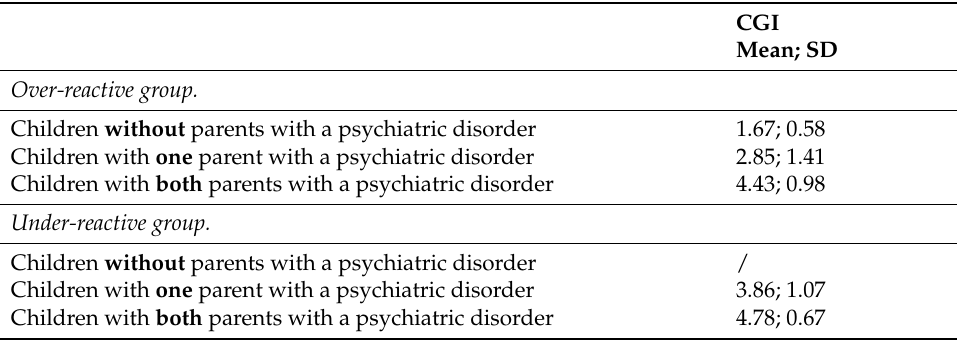
Table 3. Mean and SD for the CGI score at follow-up for the subgroups with and without parental psychiatric disorder, separately for the over and under-reactive groups.